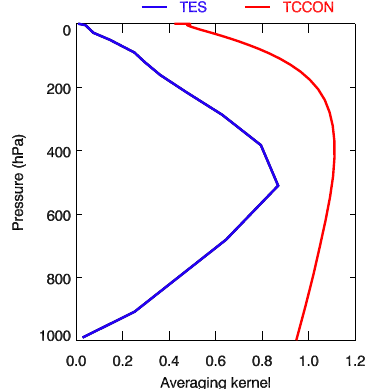
Fig. 1. Averaging kernel for TES retrieval (blue) and TCCON re- trieval